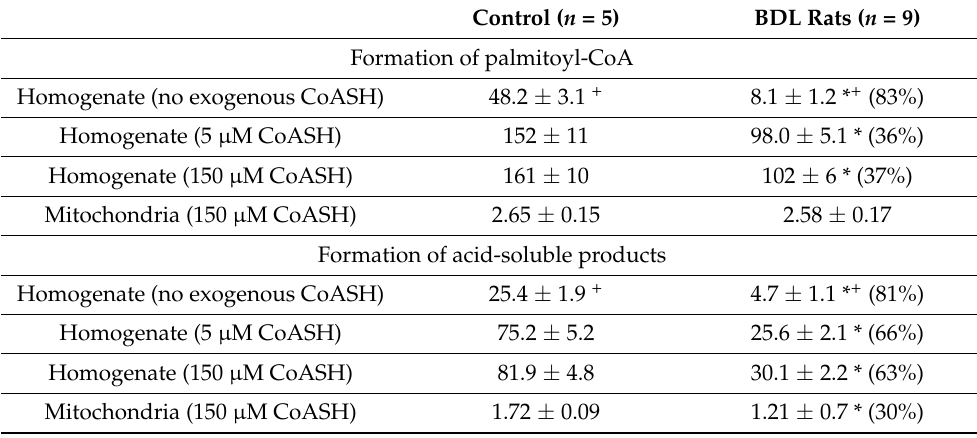
Table 3. Palmitate metabolism by liver homogenate and isolated liver mitochondria. Rats were bile duct ligated for 4 weeks (BDL rats) or sham-operated control rats and were studied in the fed state. The formation of palmitoyl-CoA and or acid-soluble products from 1- 14 C-palmitate was determined as described in Methods. The estimated CoASH concentration in the assays with homogenate without the addition of CoASH was 0.2 µ M for control and 0.04 µ M for BDL rats. The final CoASH concentration in assays with the addition of exogenous CoASH is given in parentheses. Data are presented as the mean ± SEM. The % difference in the activity between BDL and control rats is given in parentheses. Units are nmol/min/g of liver wet weight for homogenate and nmol/min/mg mitochondrial protein for isolated mitochondria. * p < 0.05 vs. control rats and + p < 0.05 vs. respective homogenate incubations at 150 µ M CoA.